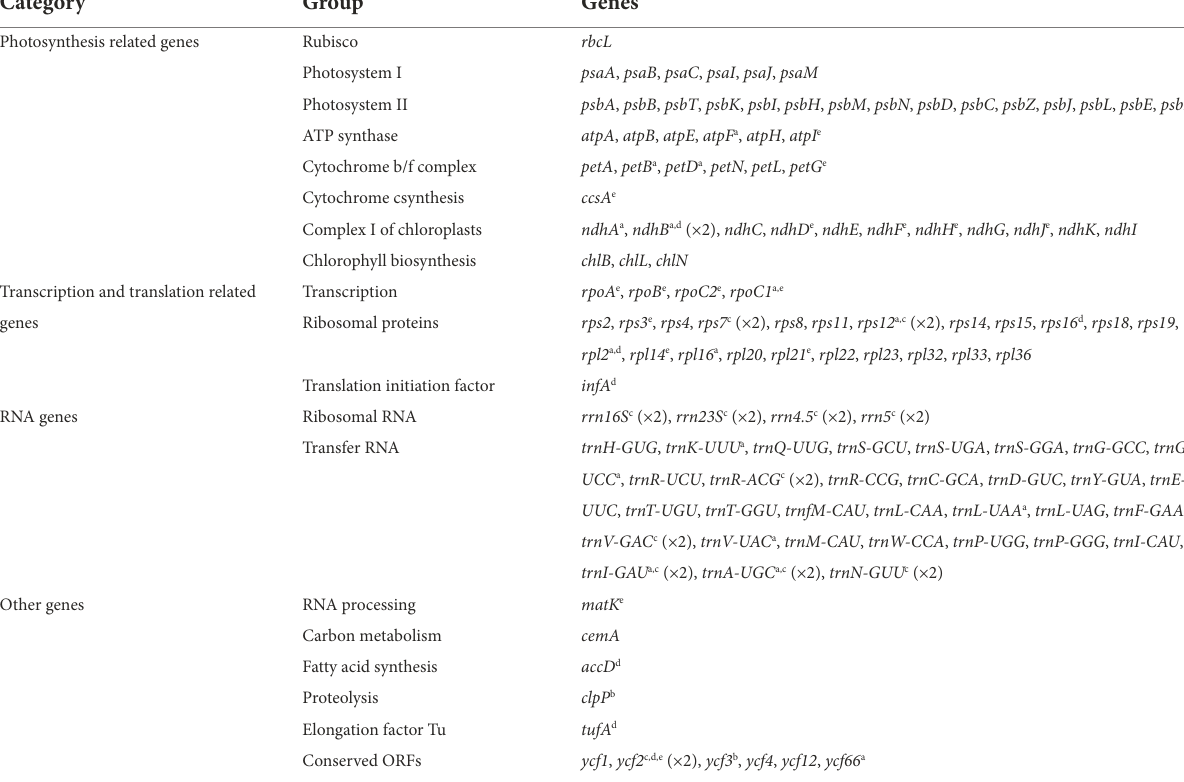
TABLE 2 Gene annotation of the Isoetes chloroplast genomes.